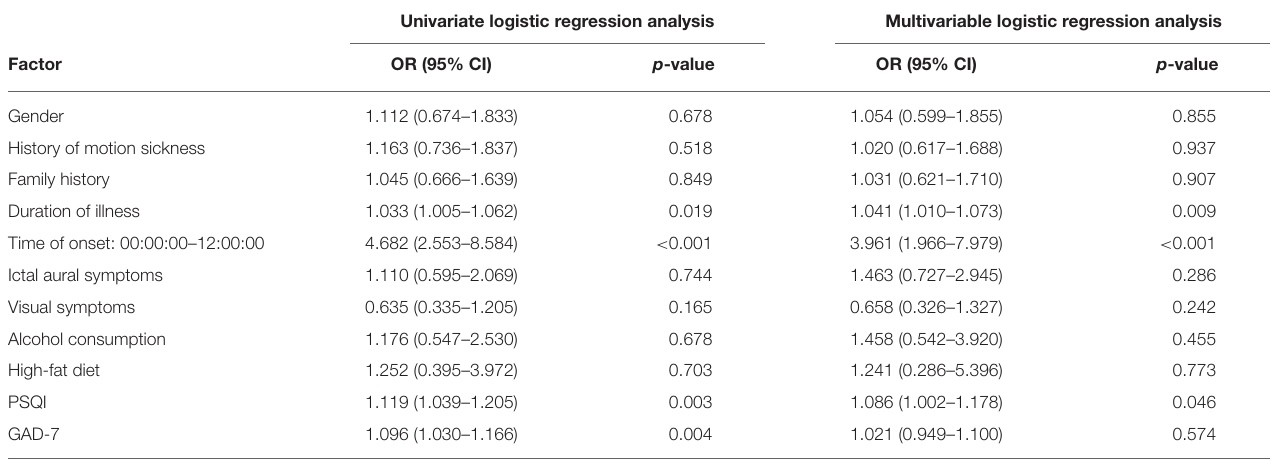
TABLE 5 | Logistic regression analysis of risk factors associated with severe attack in VM patients. Univariate logistic regression